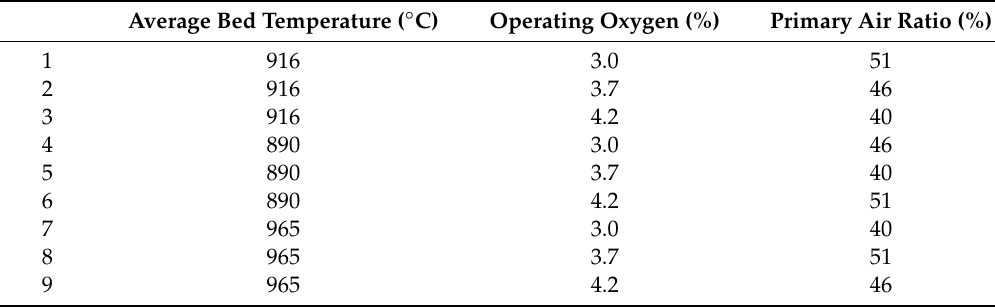
Table 4. Powder coke burning test